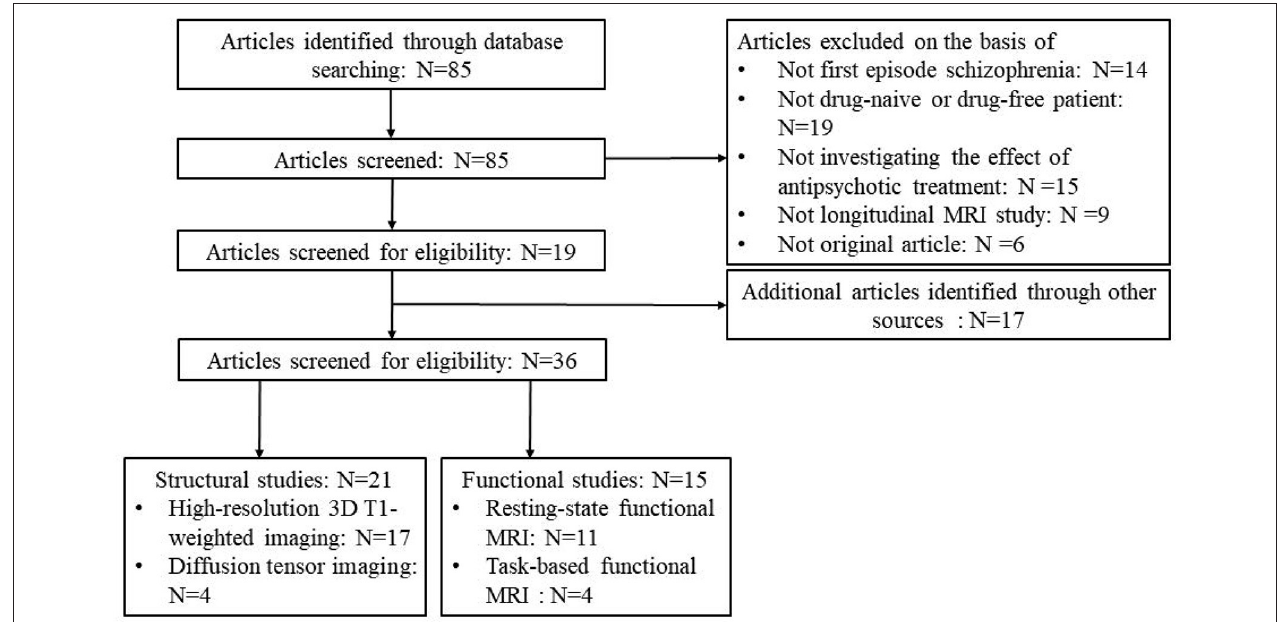
FIGURE 1 | Flowchart of the article search and selection procedure for this